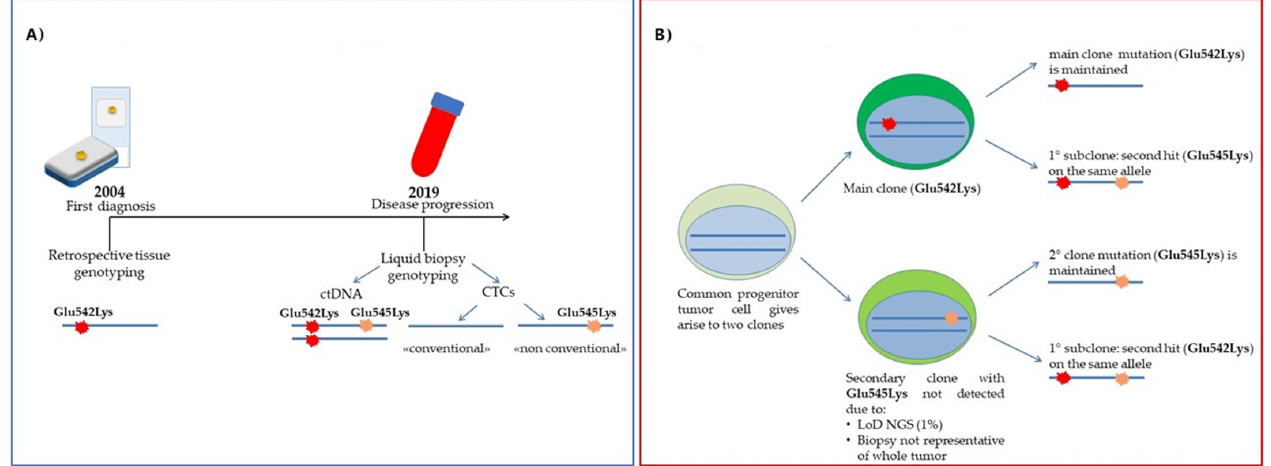
Figure 3. Case of Pt#55. ( A ) Timeline of mutational assessment; ( B ) Hypothesis of the clonal evolution of the disease: the different mutations detected in CTCs may reflect tumor heterogeneity.